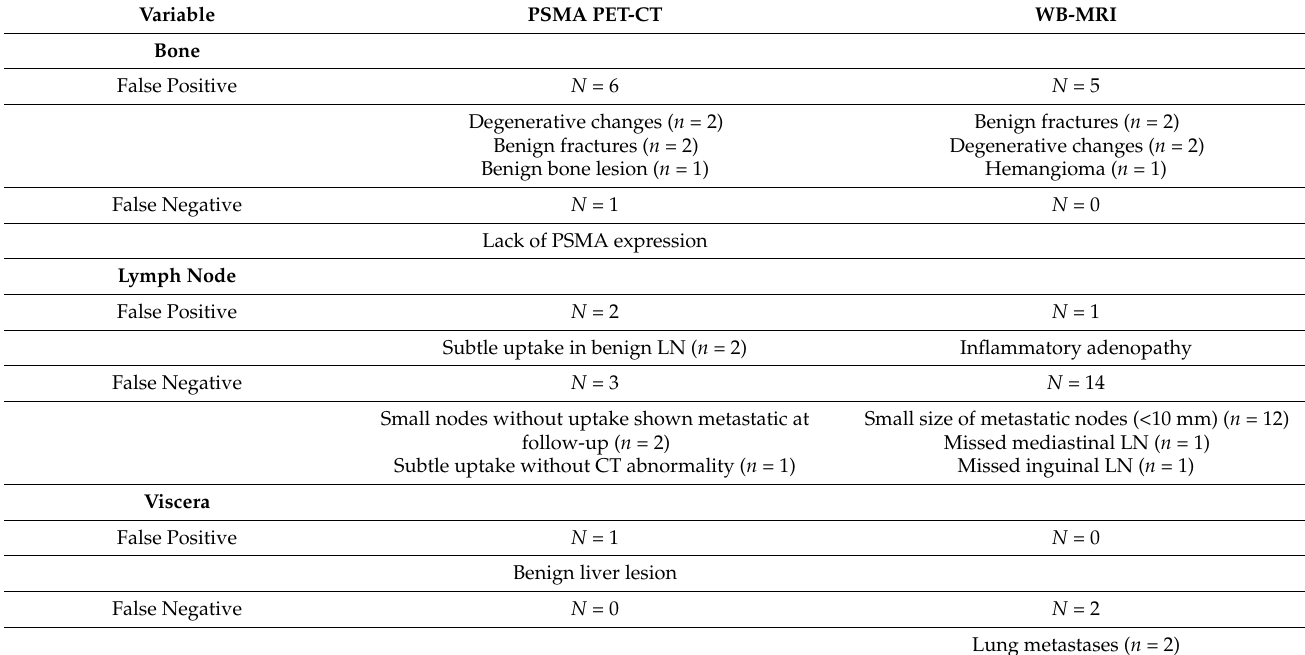
Table 3. Causes of false positive and negative observations in the patient-based analysis of the whole patient population, as adjudicated after the analysis of the files by the time of